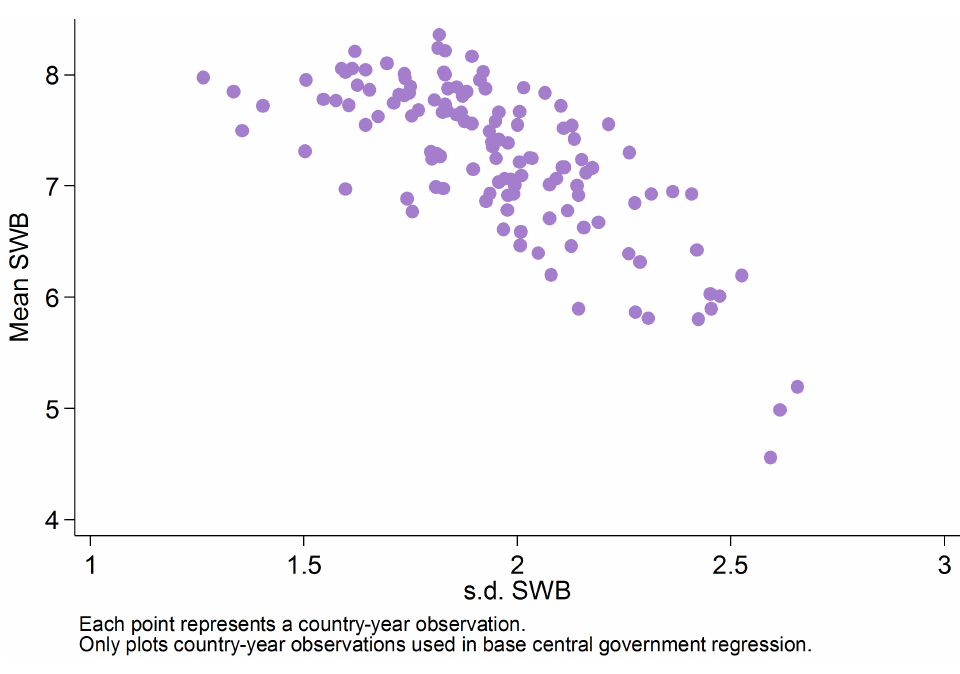
Figure A.1: Scatter plot of mean SWB vs. s.d. SWB